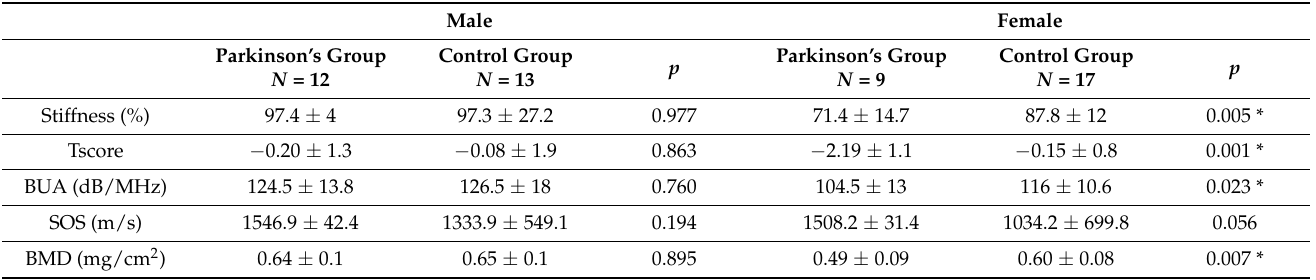
Table 3. Sex differences in bone quality parameters for each of the study groups (Parkinson’s and healthy control).